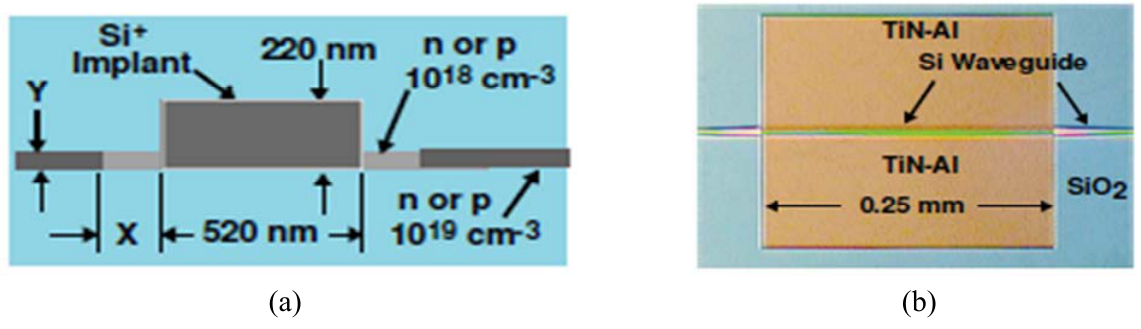
Figure 8. Top-view optical micrograph (a) and schematic cross section (b) of the integrated photodiode proposed by Geis et al. [53]. Copyright © 2009 Optical Society of America.